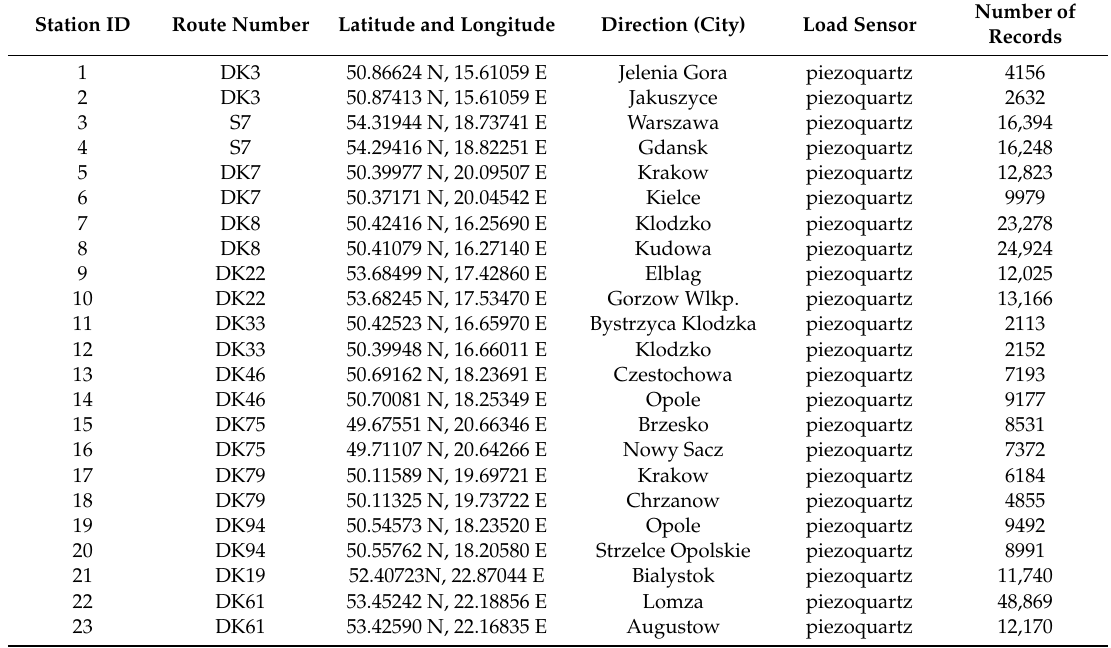
Table 1. List of WIM stations considered in the analysis and number of compound data records. Station